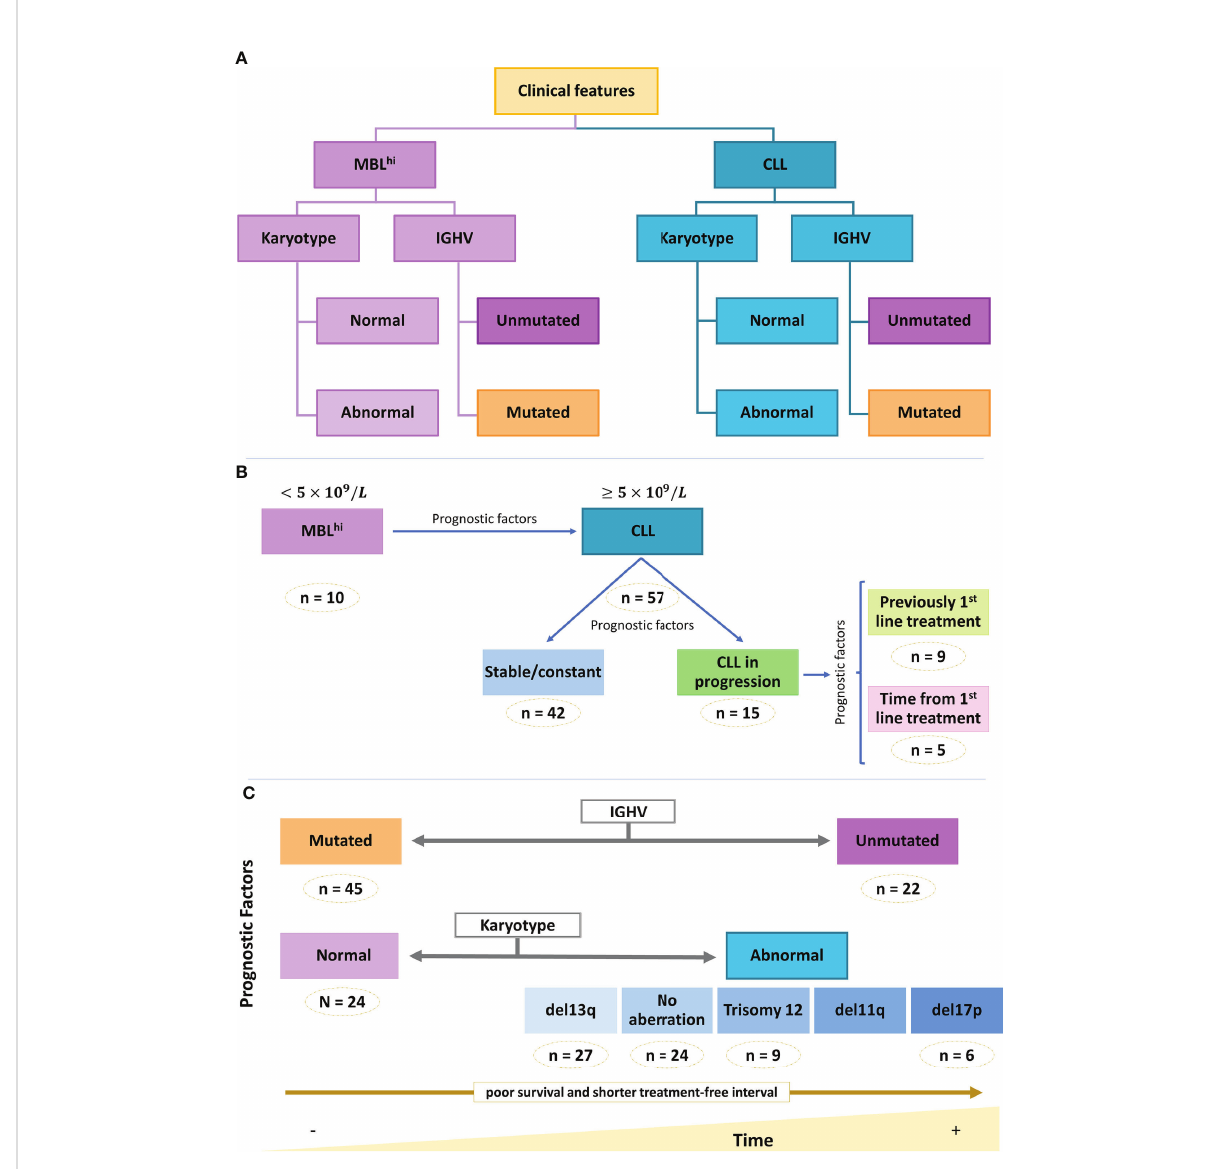
FIGURE 1 Clinical and biological info of the cohort. Schematic representation of cohort main features. (A) Diagnosis. (B) Distribution of diagnosis group. (C) Main prognostic